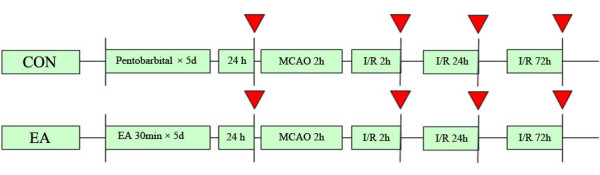
Experimental protocol diagram 2. Forty-eight male SD rats were randomly divided into 2 groups (n = 24 each): CON, EA group. At 24 h after the last EA pretreatment and 2 h, 24 h, 72 h after ischemia/reperfusion (red arrow), the rats (n = 6 for each time point) from 2 groups were anesthetized and killed. RT-PCR and Western blot analysis were performed.